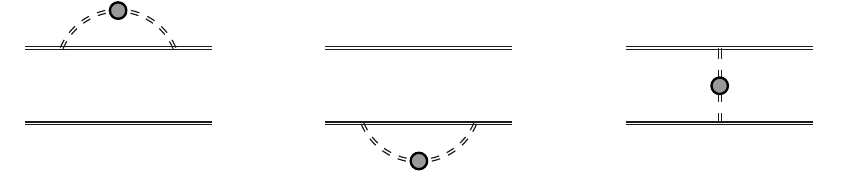
Figure 1 . Diagrams leading to a mass correction and an attractive potential between the dark matter fermion pair (double-solid line) induced by the light dark-Higgs scalar (double-dashed line). The blob stands for thermal correction to the scalar